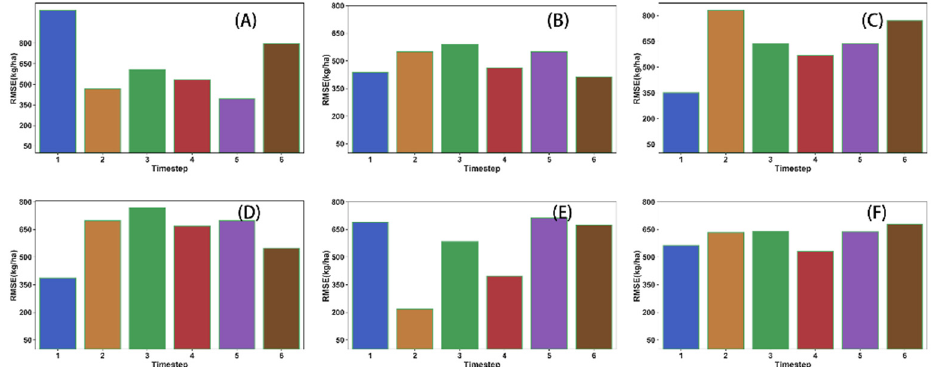
Figure 6. The model performance (predicted RMSE) using different time steps for the whole growing season. ( A ) one time step; ( B ) two time steps; ( C ) three time steps; ( D ) four time steps; ( E ) five time steps; and ( F ) six time steps.